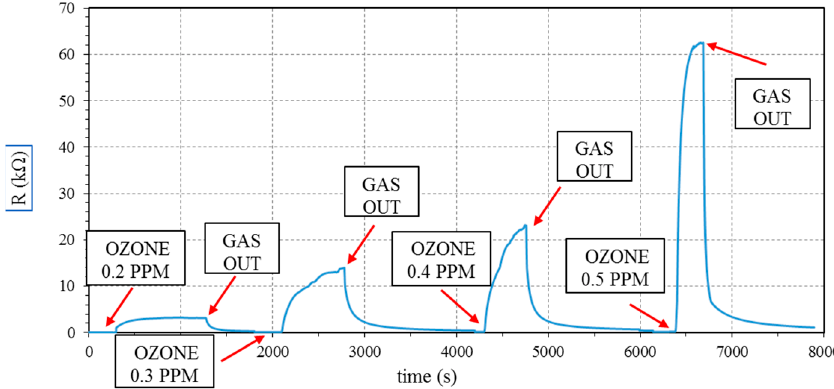
Figure 3. Resistance variation of W-In 2 O 3 sensor under 200–500 ppb ozone concentration at 75